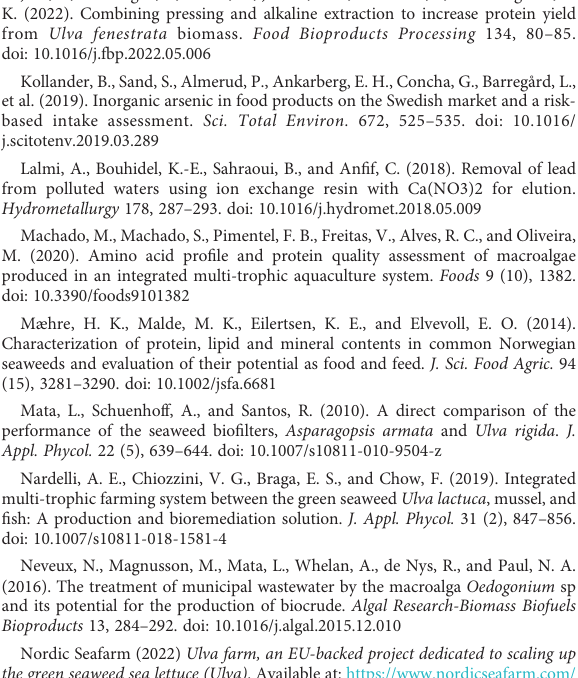
ulva-farm (Accessed 15 August